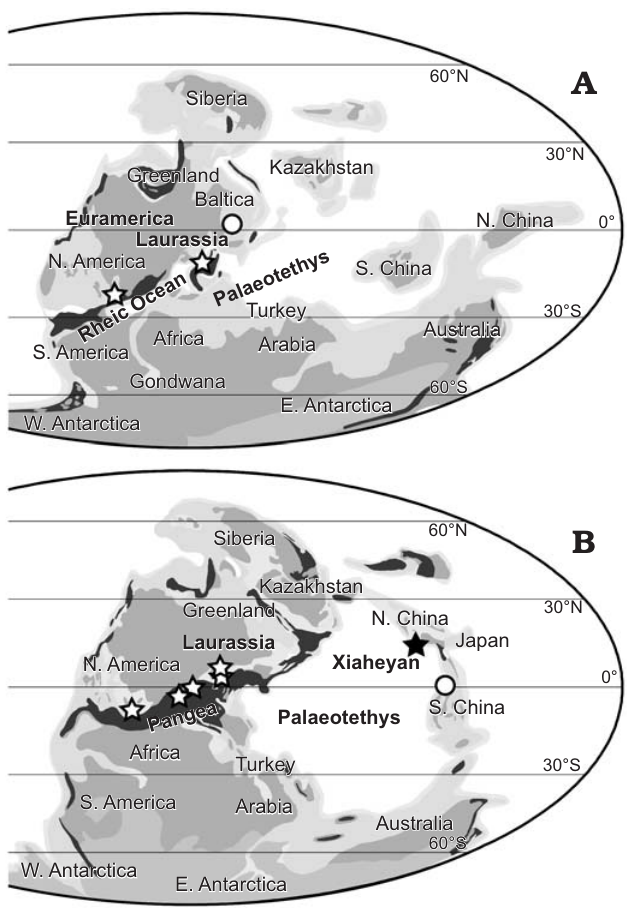
Fig. 1. Occurrences of Late Devonian ( A ) and Carboniferous ( B ) teallio- caridids (modified from Golonka 2000 and Gueriau et al. 2014). Circles indicate uncertain assignment to tealliocaridids. The black star indicates the Xiaheyan locality, white stars other localities which delivered teallio- caridids. The different shades of gray indicate deep oceans (white), shallow seas (light gray), land (medium gray), and mountain chains (dark